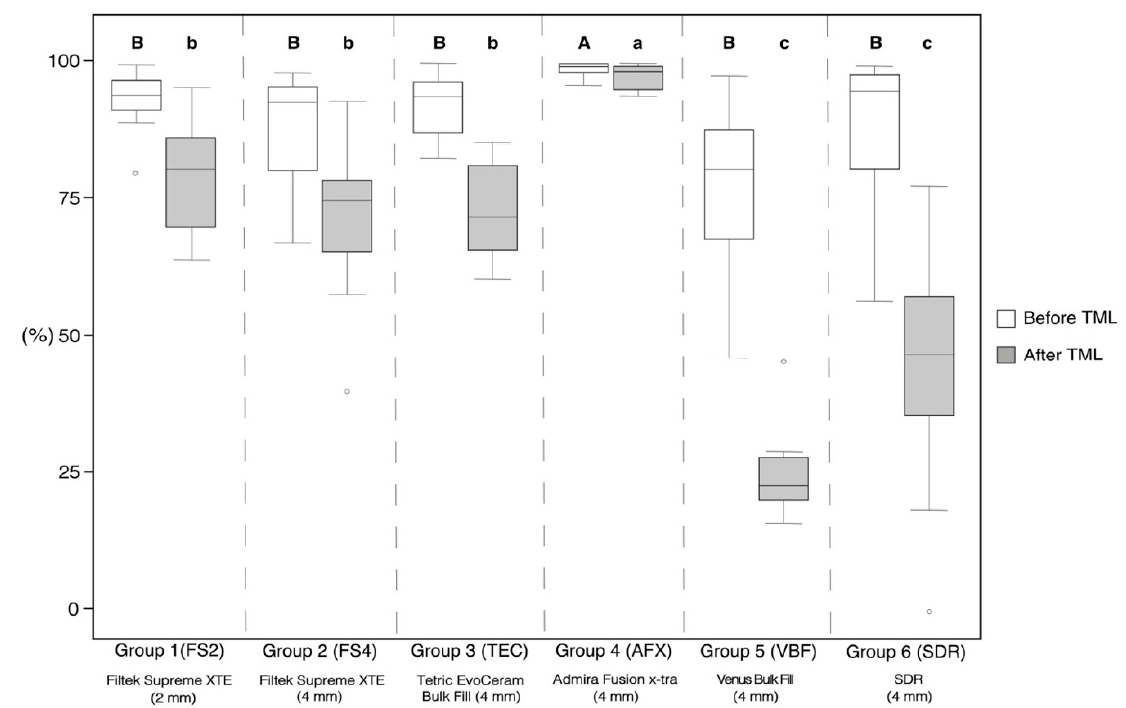
Figure 5. Margin integrity for the total margin length, given as percentages of continuous margins for all experimental groups before and after thermo-mechanical loading (TML). The boxplots represent the medians (black lines) with 25% and 75% quartiles (boxes). The whiskers represent 1.5*IQR (interquartile range), or minima and maxima of the distribution if below 1.5*IQR. Outliers are shown as circles. Statistically significant di ff erences ( p < 0.05) in the percentage of continuous margins between di ff erent groups are marked with di ff erent letters (capital and lower-case letters refer to the situation before and after TML, respectively). All groups showed a significant decline in margin integrity after TML ( p < 0.05, respectively). Table 2. Margin integrity, separately in enamel and dentin, given as percentages of continuous margins (mean ± standard deviation) for all experimental groups before and after thermo-mechanical loading (TML).